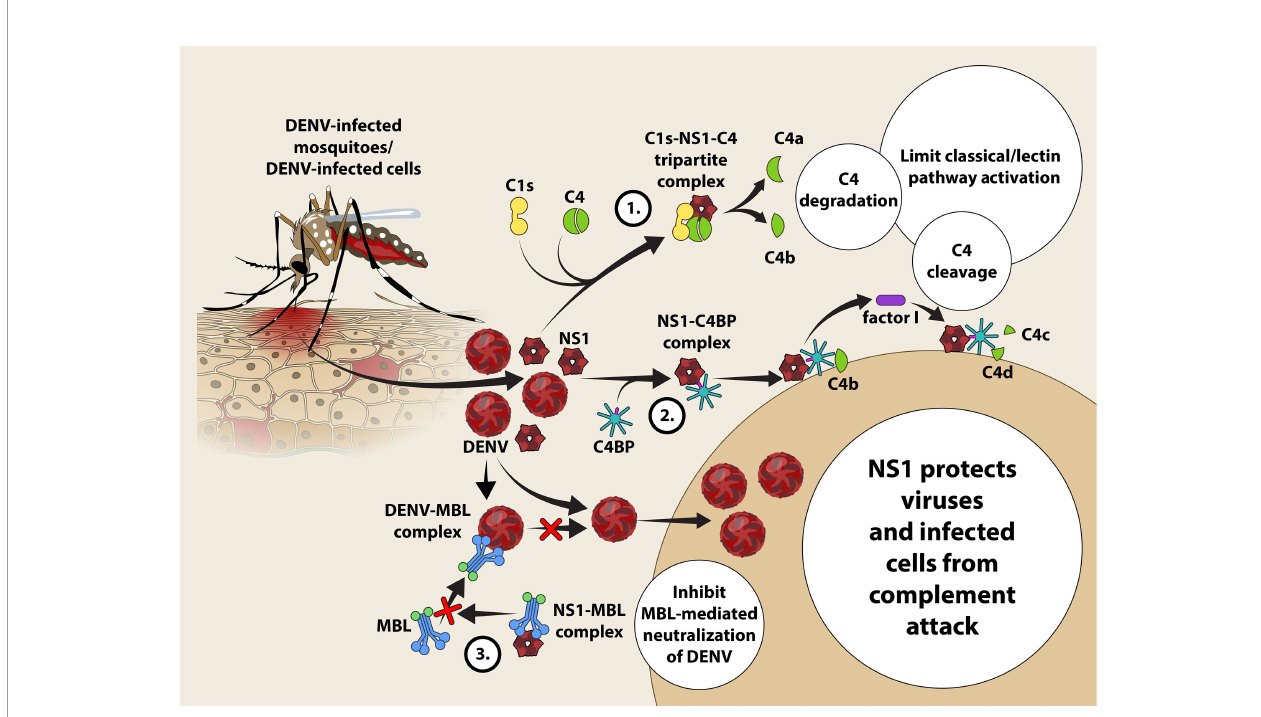
FIGURE 2 | Proposed mechanism of evasion of DENV and DENV-infected cells from classical and lectin pathway-mediated complement attack in the host. NS1 protein released by DENV-infected cells activates the classical pathway of complement activation resulting in the formation of a tri-partite C1S-NS1-C4 complex. C4 undergoes enzymatic cleavage forming C4a (anaphylatoxin and chemotaxin) and C4b present in the fl uid phase becomes susceptible to spontaneous hydrolysis attributing to paucity of C4 in the circulation (33). NS1 recruits C4BP and binds with it leading to subsequent recruitment of C4b to engage with the NS1-C4BP complex to allow the ‘ stepping-in ’ of factor I. Factor I is a negative regulator of complement activation that cleaves C4b into C4c and C4d fragments to limit the classical as well as the lectin pathways (34). Competitive binding of NS1 to MBL prevents recognition of DENV by MBL that protects DENV from neutralization by